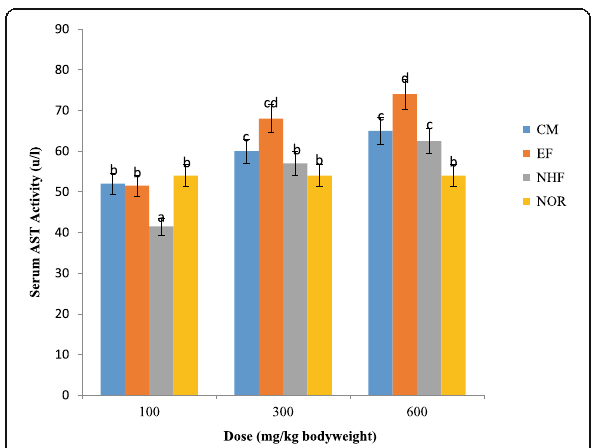
Fig. 1 Effect of crude extract and fractions of Gymnema sylvestre on serum aspartate aminotransferase of rats. Mean with different superscripts differ significantly ( p < 0.05). Key: NOR: normal control,